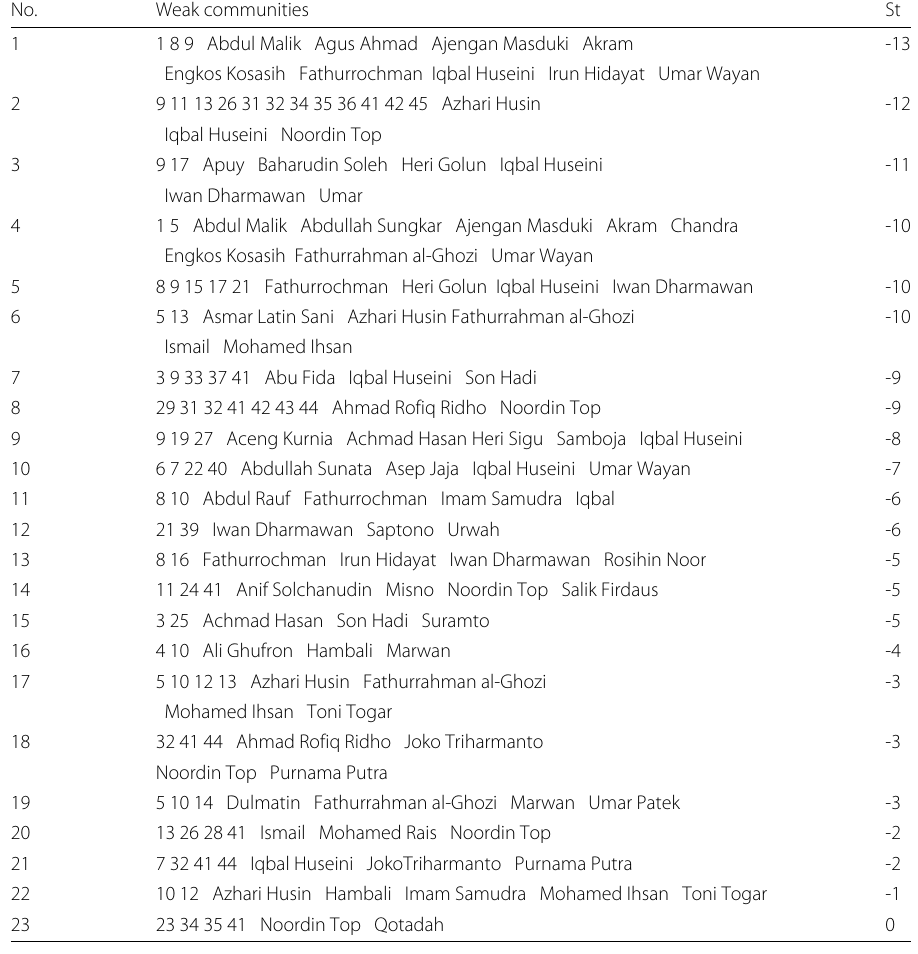
Table 9 The 23 weak communities identified using MaxBic in Noordin Top terrorist network No. Weak communities